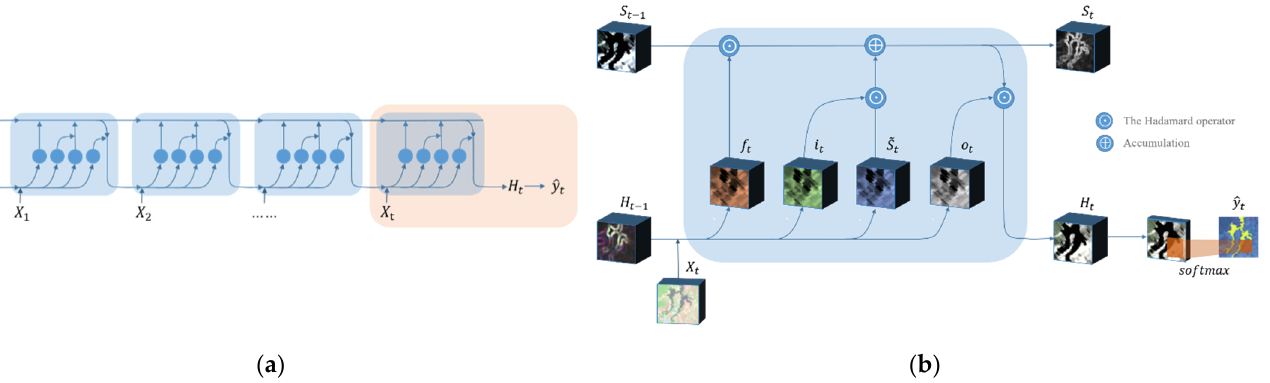
Figure 3. Schematic illustration of convolutional LSTM network architectures. ( a ) The process of convolutional LSTM for a time series input ( X 1 , X 2 , . . . , X t ) ; ( b ) a neural cell of input X t at time t , where the pink box in ( a